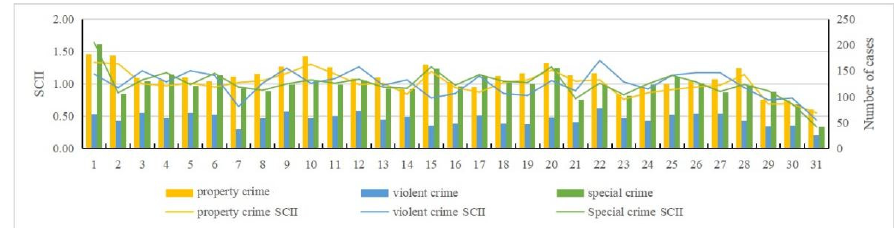
Figure 4. Standardized day scale crime intensity index and number of cases.